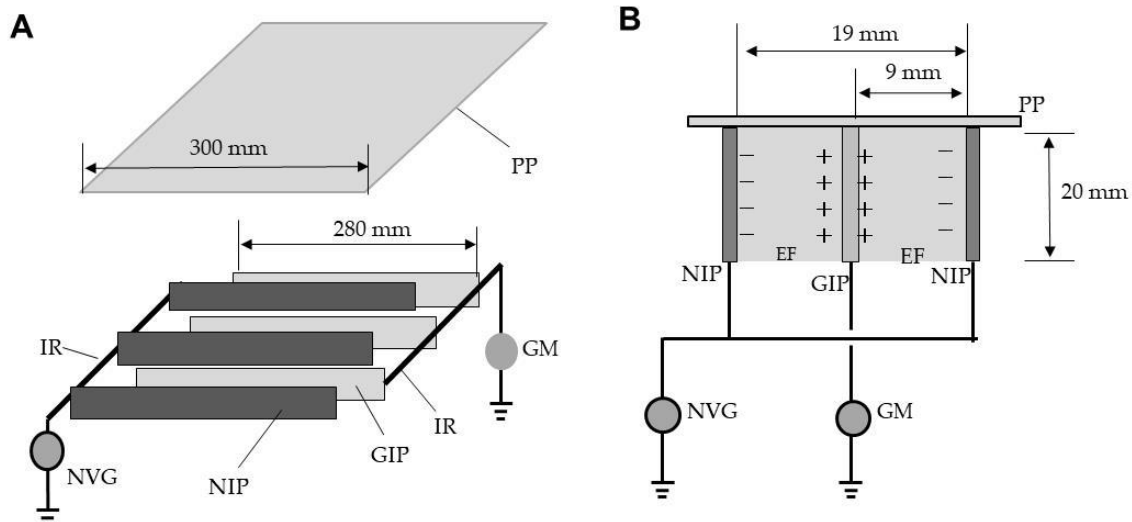
Figure 1. The arc discharge exposer (ADE) ( A ), in cross-sectional view ( B ). Abbreviations: PP, polypropylene plate (insulator); IR, iron rod; NVG, negative voltage generator; NIP, negatively charged iron plate (conductor); GIP, grounded iron plate (conductor); GM, galvanometer; EF, electric field.